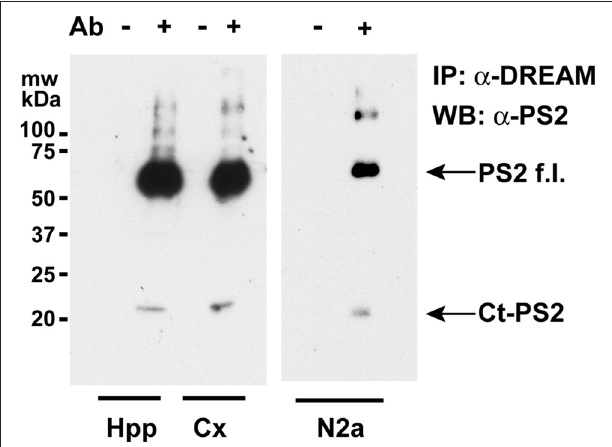
FIGURE 1 | Coimmunoprecipitation of endogenous DREAM and presenilin-2 (PS2) proteins. Western blots of immunoprecipitated PS2 from mouse hippocampal (Hpp) and cortical (Cx) extracts (left) or from N2a whole cell extracts (right), with (+) or without ( − ) an anti-DREAM antibody (Ab), and developed with an antibody against PS2. Bands corresponding to the Ct-PS2 fragment and the full length PS2 holoprotein (PS2f.l.) are shown by